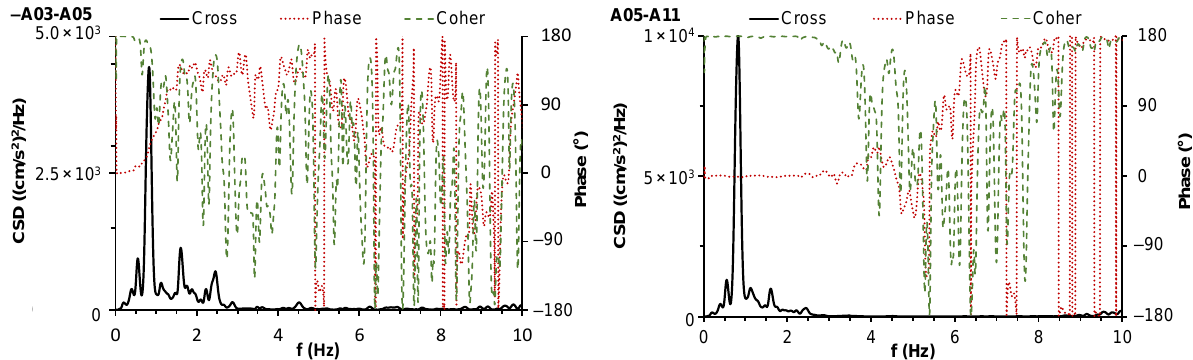
Figure 10. CSD of sensors in y direction at different levels (the coherence varies in [0,1]). By means of a double integration in the frequency domain, the time histories of the displacements (Figure 11) were obtained from the acceleration time histories. The maximum values of the horizontal displacements of the gravity centers at L0, L1 and L2 were 27.3, 31.8 and 32.0 mm,